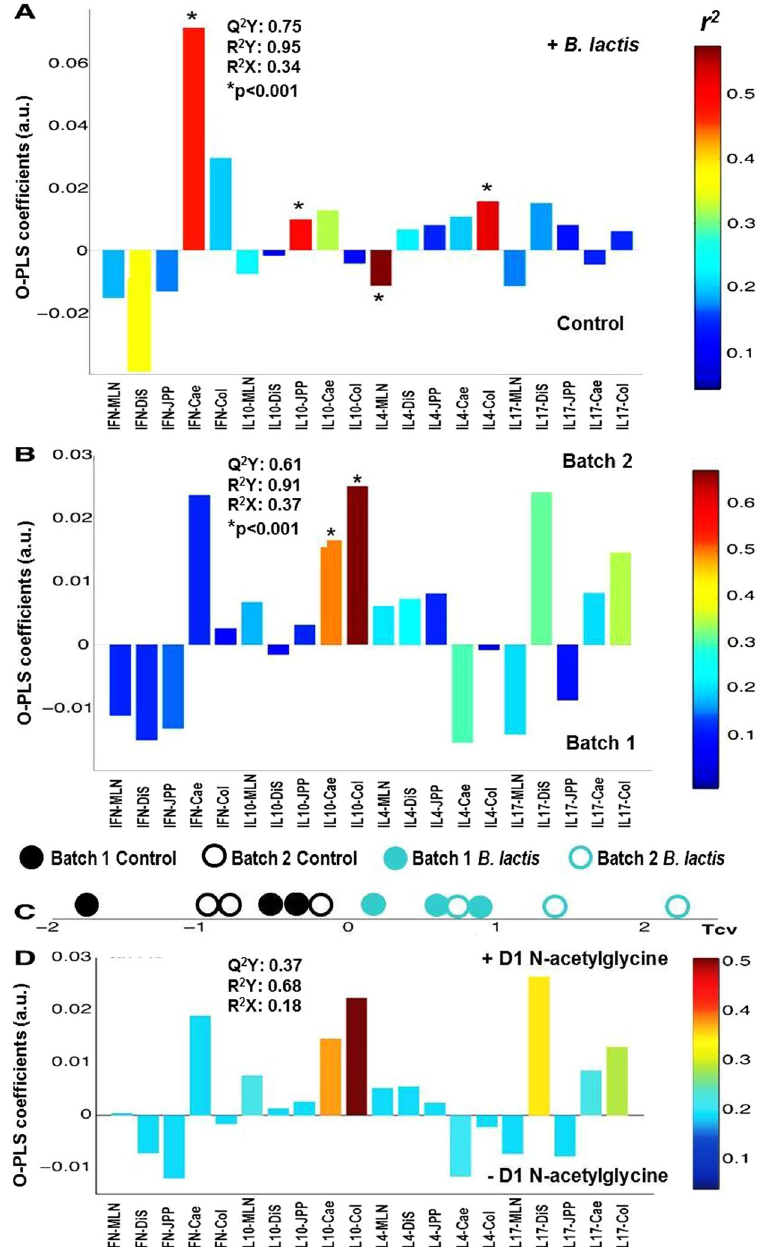
Figure 3. Mucosal cytokines synthesis is affected by both experimental batch and early supplementation with B.lactis NCC2818 while early inflammatory markers predict later cytokine synthesis. Back-scaled correlation covariance plots derived from a pairwise O-PLS-DA model comparing the effect of B. lactis NCC2818 supplementation on cytokine production in immunological tissues ( a ). The bars pointing upwards denote cytokines that are relatively increased in animals supplemented with B.lactis NCC2818 from 1 day (n = 6)–an increasing colour intensity of red depicts the strength of this association ( r 2 ) and model statistics can be seen in the upper left hand corner. The experimental batch significantly affected 35 day cytokine production ( b ); the bars pointing upwards denote those cytokines that are relatively increased in batch 2 (n = 6). The cross-validated scores of O-PLS model using 24-hour serum N-acetylglycoproteins as a Y variable to predict 35 day cytokine production is shown in ( c ) with the legend above. Figure ( d ) depicts the corresponding loadings plots with bars above the axis representing cytokines associated with a relatively higher level in 1 day serum